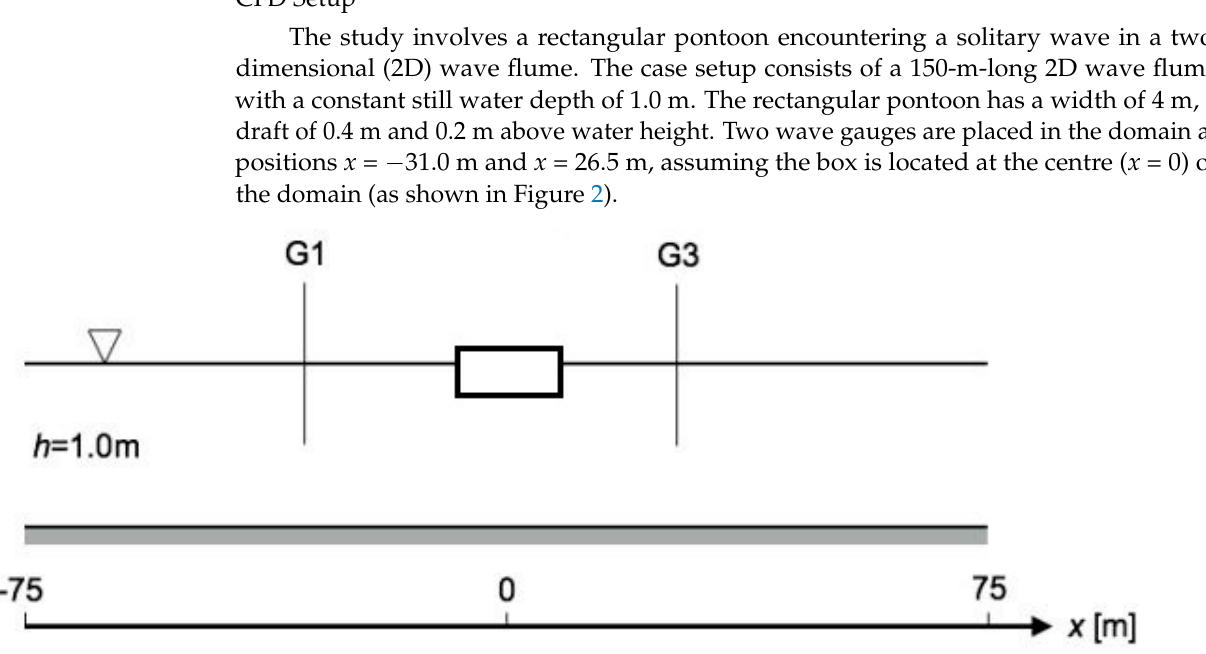
Figure 2. Schematic diagram of the case setup of the solitary wave scattering by a pontoon (not to